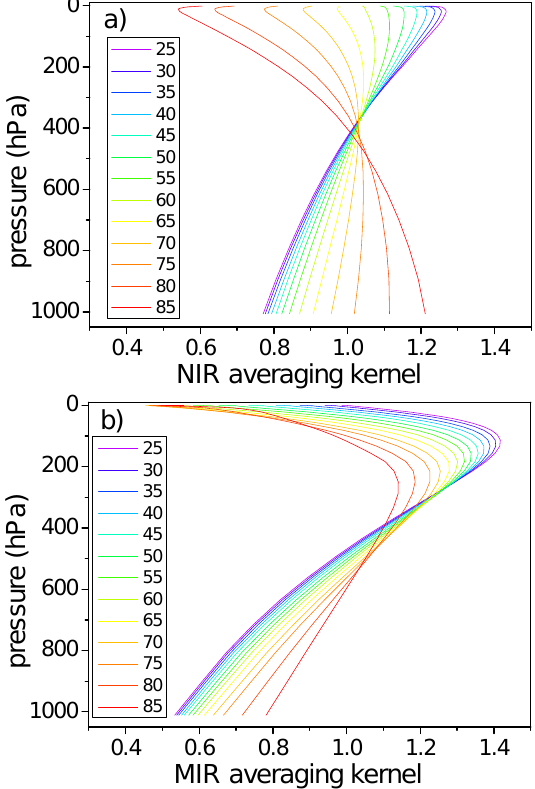
Fig. 2. Averaging kernels (a) for the NIR retrievals and (b) the MIR retrievals. Solar zenith angles (in deg) are color